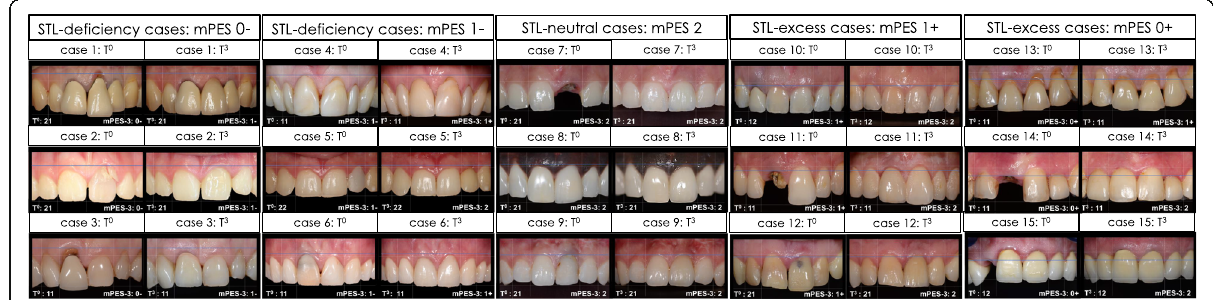
Fig. 1 Three examples of cases with comparable pre-operative soft tissue level (STL) and their STL at T 3 ; STL-deficiency > 2 mm (mPES = 0 − ),